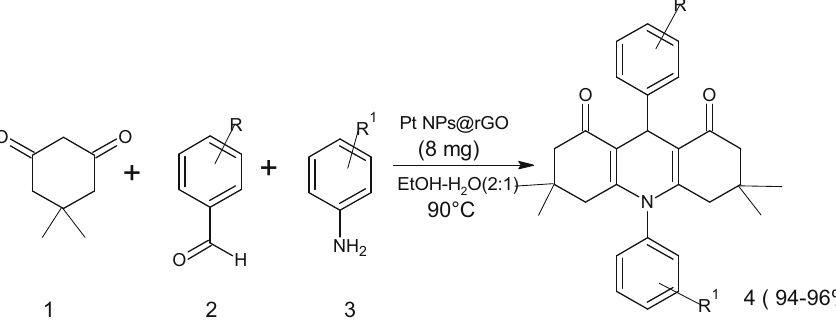
Scheme 7: Synthesis of acridinedione derivatives in the presence of Pt NPs@rGO.